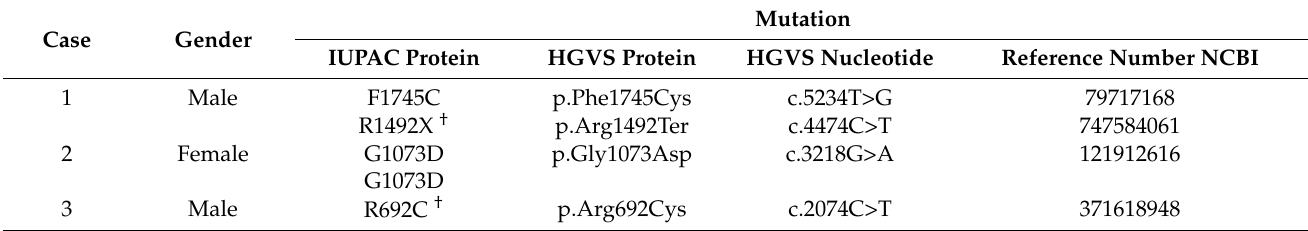
Table 2. Molecular analysis of patients with congenital sucrase-isomaltase deficiency included in the present study.